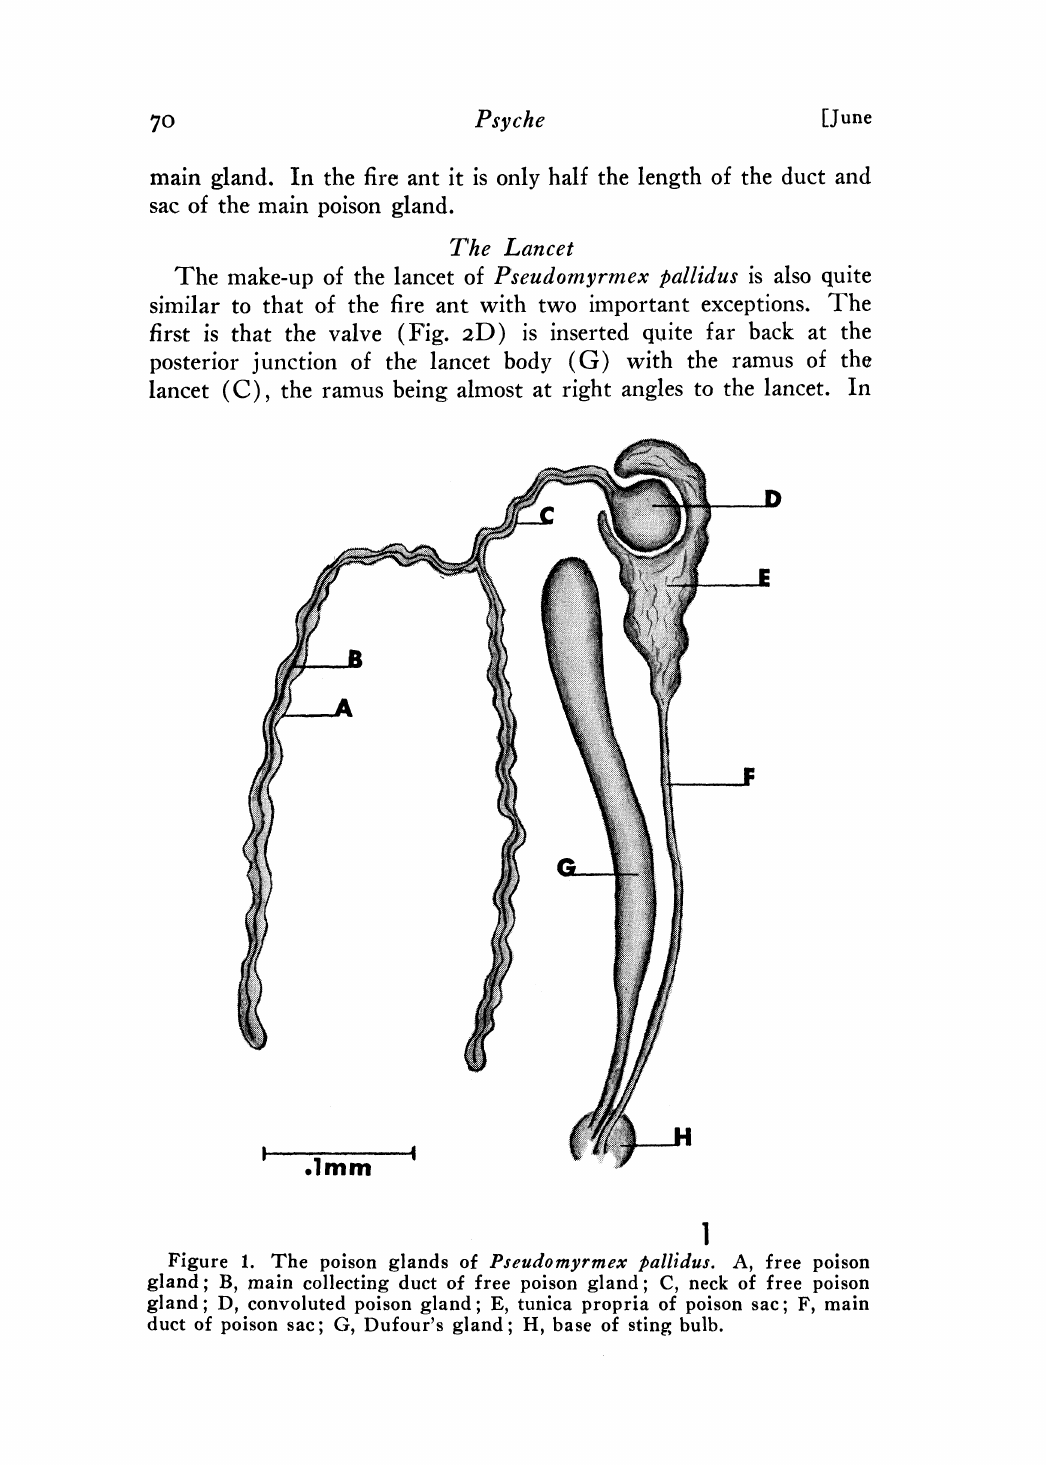
Figure 1. The poison glands of Pseudomyrmex [allidus. A, free poison gland; B, main collecting duet of free poison gland; C, neck of free poison gland; D, convoluted poison gland; E, tuniea propria of poison sac; F, main duet of poison sac; G, Dufour’s gland; H, base of sting